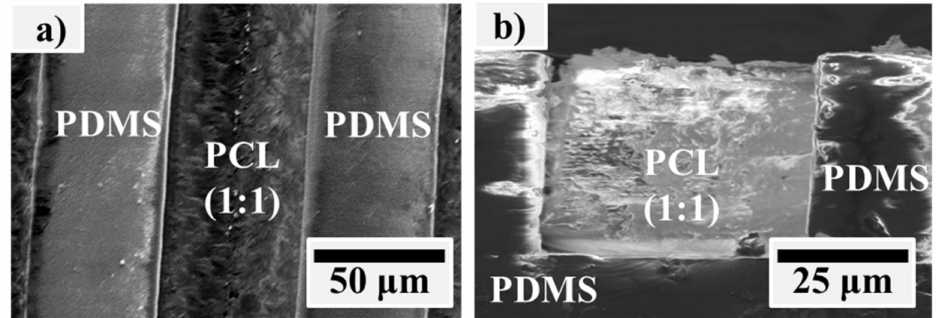
Figure 2. SEM images of the fabricated PCL/PDMS micro structure from the ( a ) top view and ( b ) side